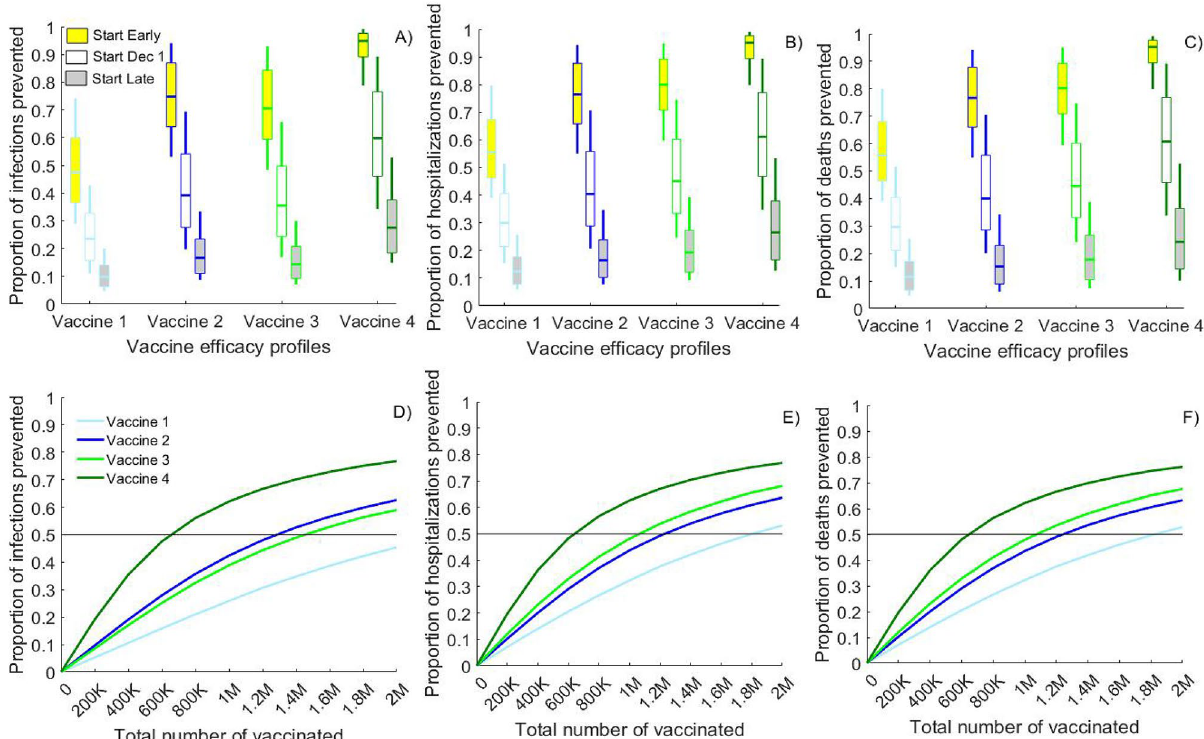
Figure 4. Importance of the timing and the coverage achieved with the vaccine rollout. Comparison of the projected reductions in the number of: ( A , D ) cumulative infections; ( B , E ) cumulative hospitalizations and ( C , F ) cumulative deaths over 1 year due to the use of vaccines with different efficacy profiles compared to base-case scenarios without vaccination. ( A – C ) compare vaccine rollouts which start on Dec. 1, 2020 (white boxes), Sept. 1, 2020 (yellow boxes) or March 1, 2021 (gray boxes) assuming 5000 vaccinated daily till 1,000,000 vaccinations are reached. ( D – F ) show the impact of rollouts starting on Dec. 1, 2020 and reaching different number of total vaccinations over 200 days. Vaccine 1 (10% VE SUSC and 44.4% VE SYMP ) and Vaccine 2 (40% VE SUSC and 16.7%